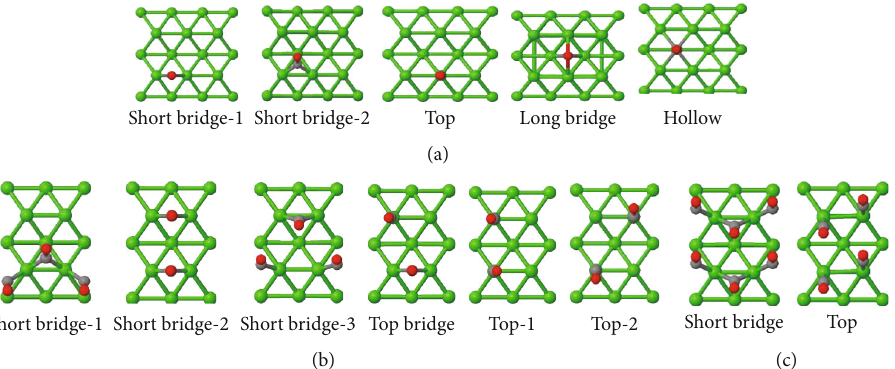
Figure 1: Top views of adsorption sites for di ff erent coverages: (a) 1/6 monolayer CO coverage; (b) 1/2 monolayer CO coverage; (c) full monolayer CO coverage. Table 1: Total energy, absorption energy, and vibration frequency of fi ve absorption con fi gures at di ff erent CO coverages. CO